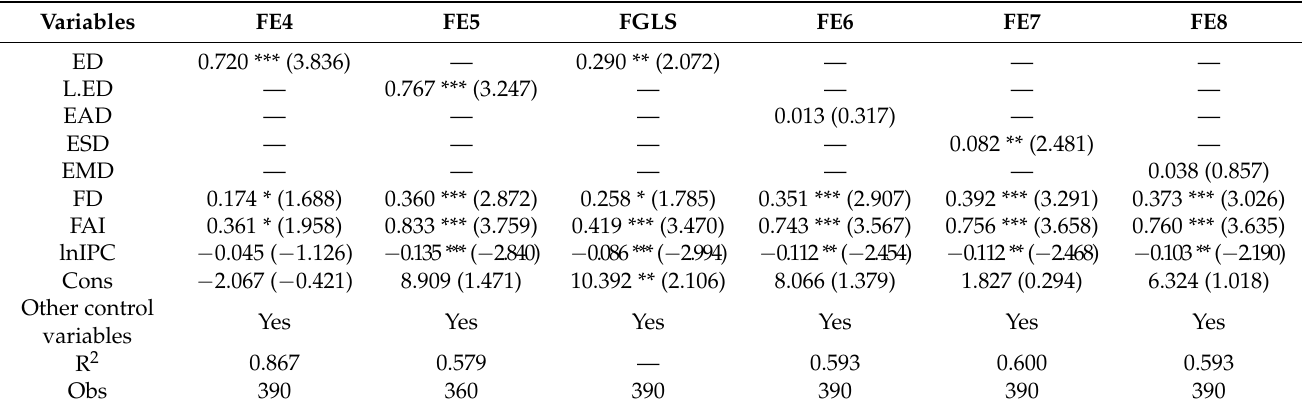
Table 4. Robustness test